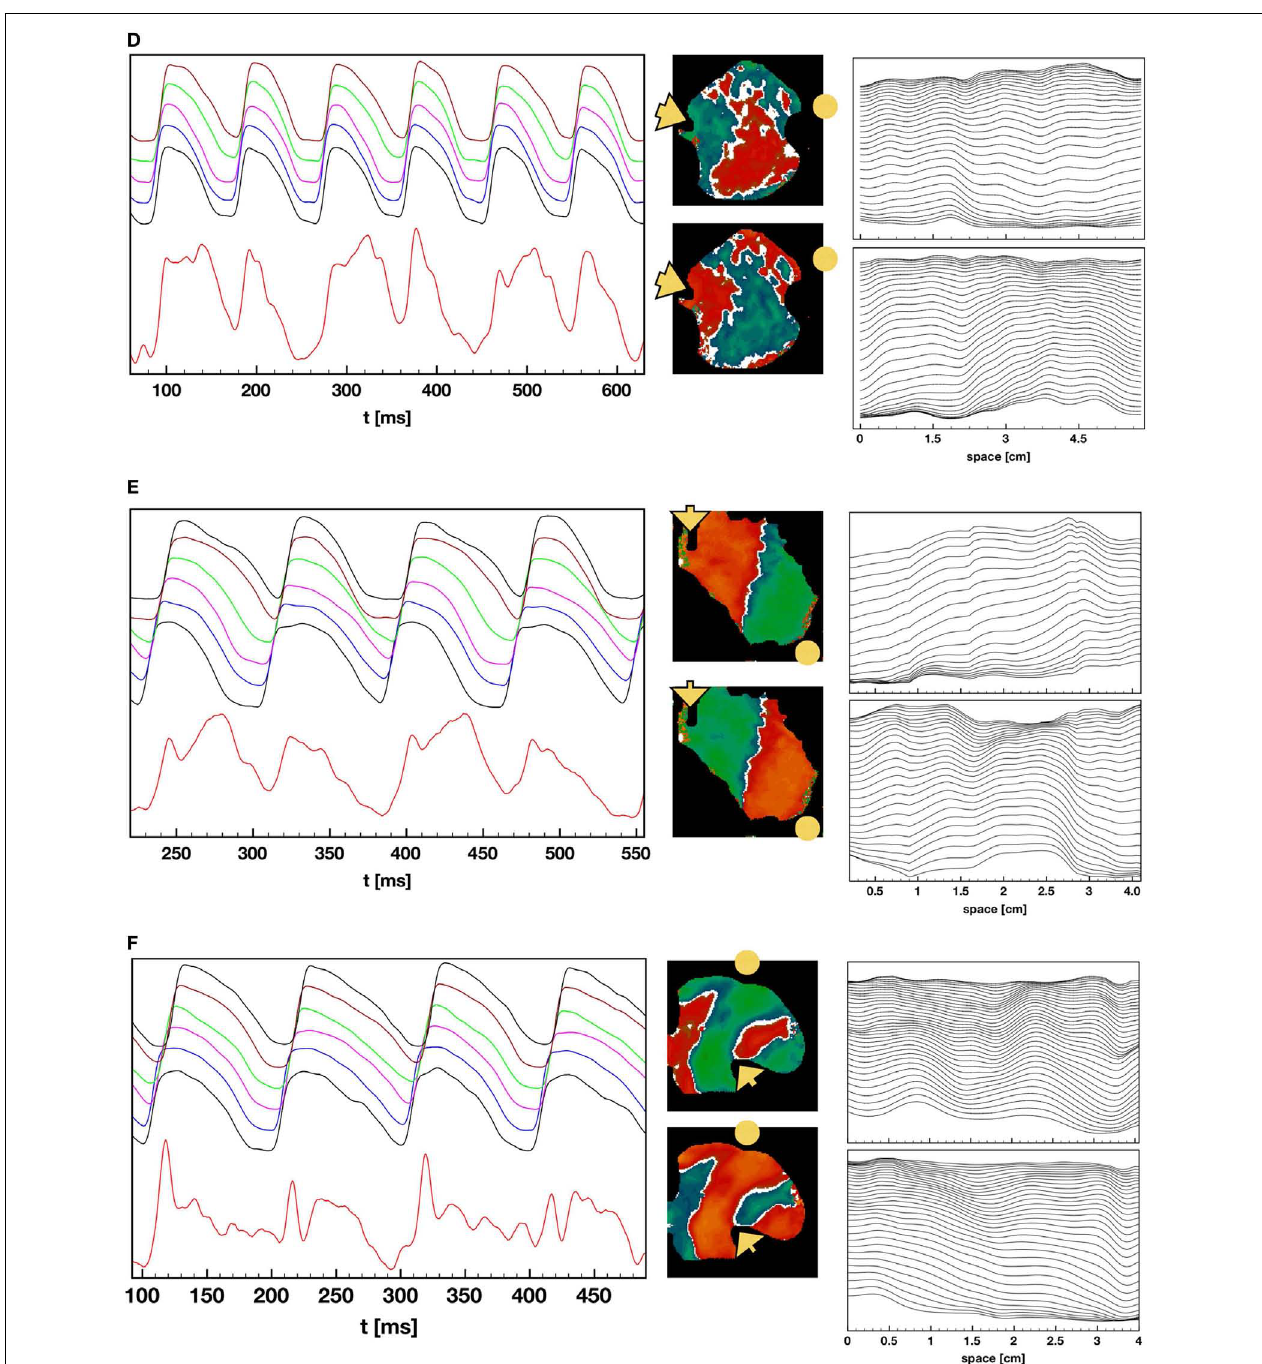
plots as in (A) but during 2:2 concordant alternans.The center plot displays the difference in APDs in the tissue for two consecutive beats.The rightmost plot shows wave backs at multiple times along a line for the two consecutive beats, indicating that the tissue depolarizes and repolarizes in different ways for the two beats. Propagation is from left to right and the voltage values are separated 2ms in time. (C–E) Pseudo-ECG, AP, APD difference, and wave back plots as in (B) but for three cases of discordant alternans, where the wave back dynamics is more complex between beats due to nodal lines. (F) Pseudo-ECG, AP, APD difference, and wave back plots as in (B) but for a particular case of discordant alternans, where multiple defined regions with opposite phase are